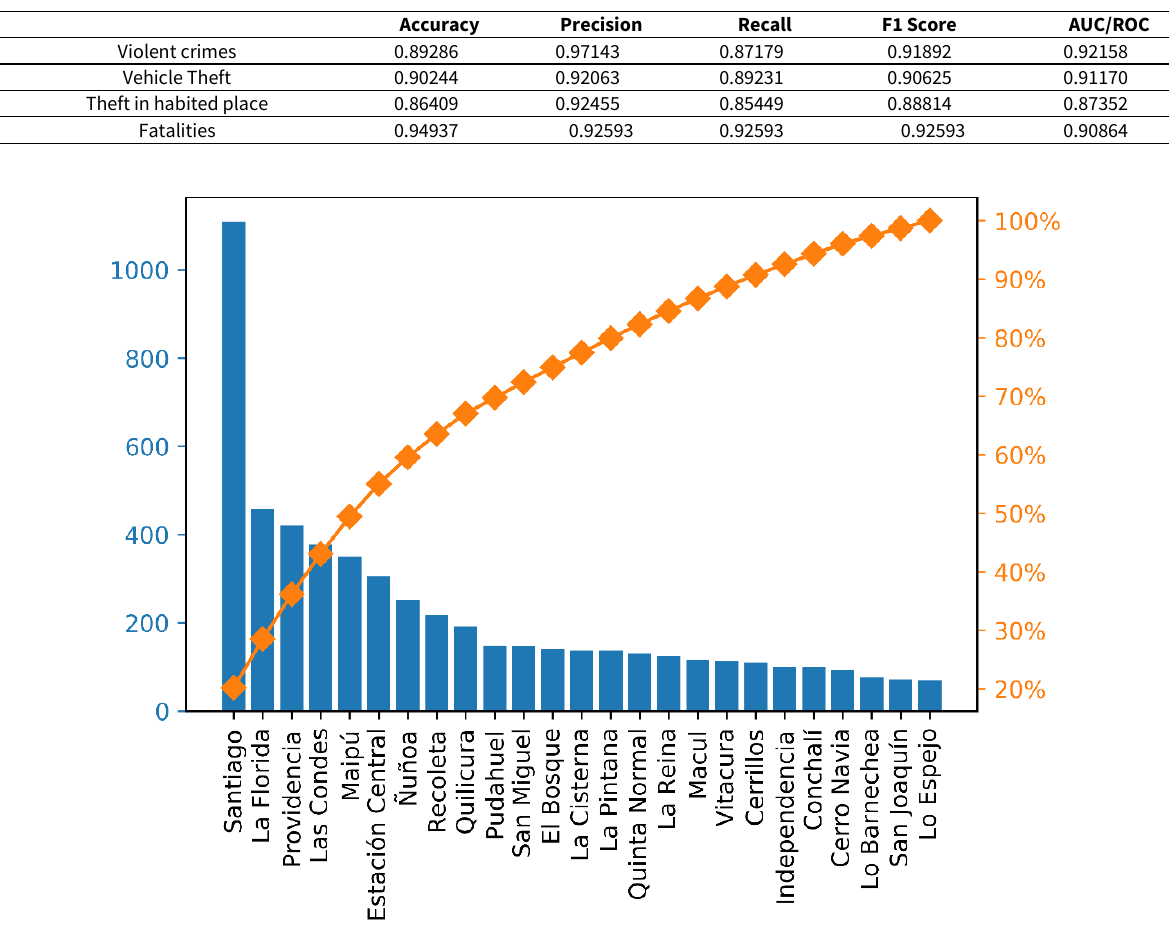
Table 2. Classification results